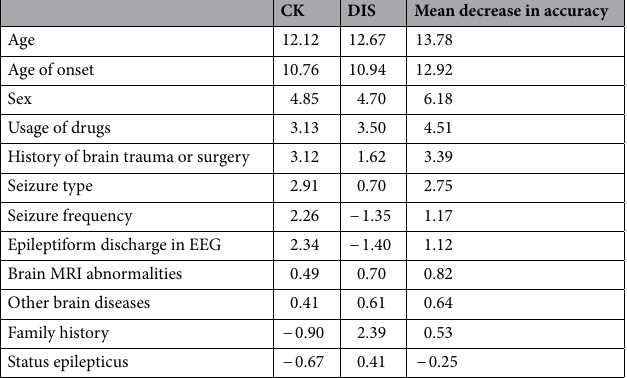
Table 3. Ranking of feature importance in the RF model (MMSE). CK control check; DIS disease—people with epilepsy.